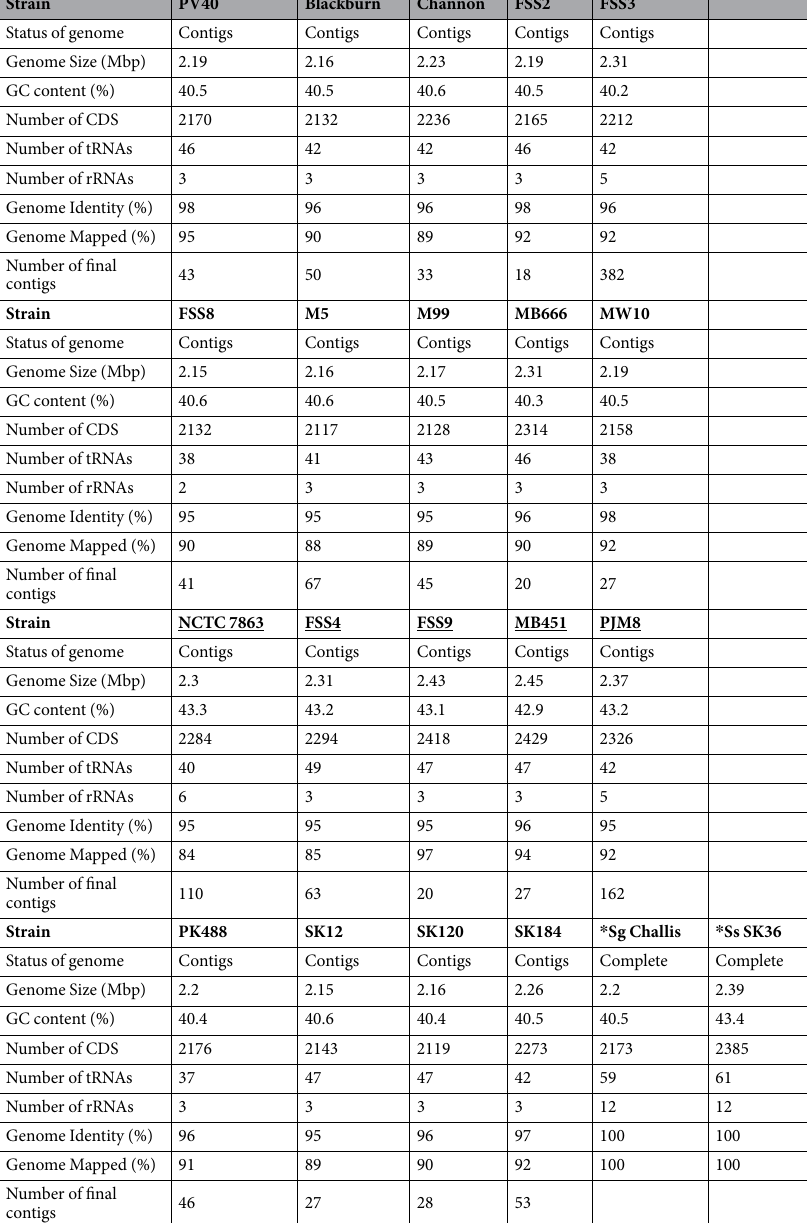
Table 1. Summary of the genome features of 19 newly sequenced Streptococcu s strains. The details include genome size, GC content (%), number of coding sequences (CDSs), tRNAs, rRNA, genome identity and the percentage of the genome mapped to the reference. There are a total of 14 Sg strains and 5 Ss strains (underlined). The reference genomes of Sg Challis and Ss SK36 are marked with